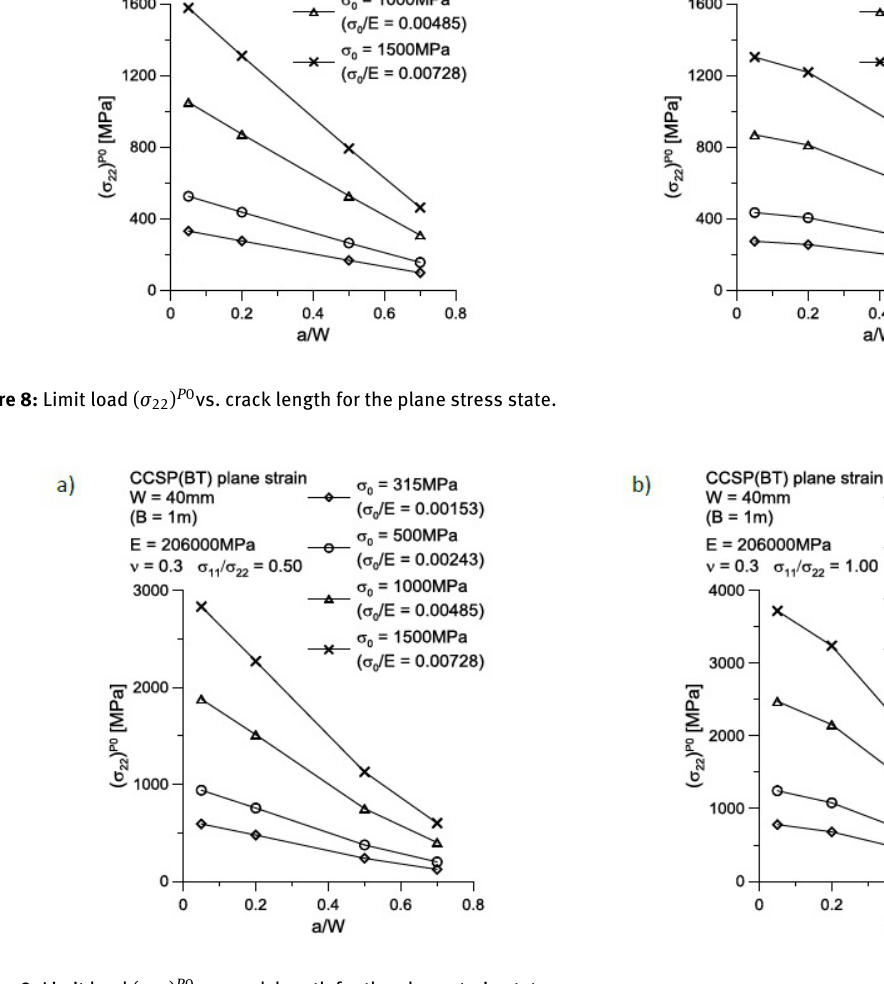
Figure 9: Limit load ( σ 22 ) P 0 vs. crack length for the plane strain state.